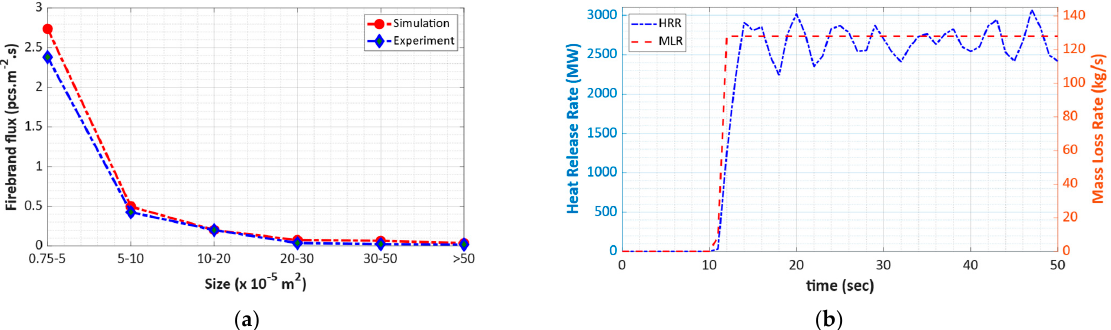
Figure 15. ( a ) Total firebrand flux comparison between the simulation and the experiment for